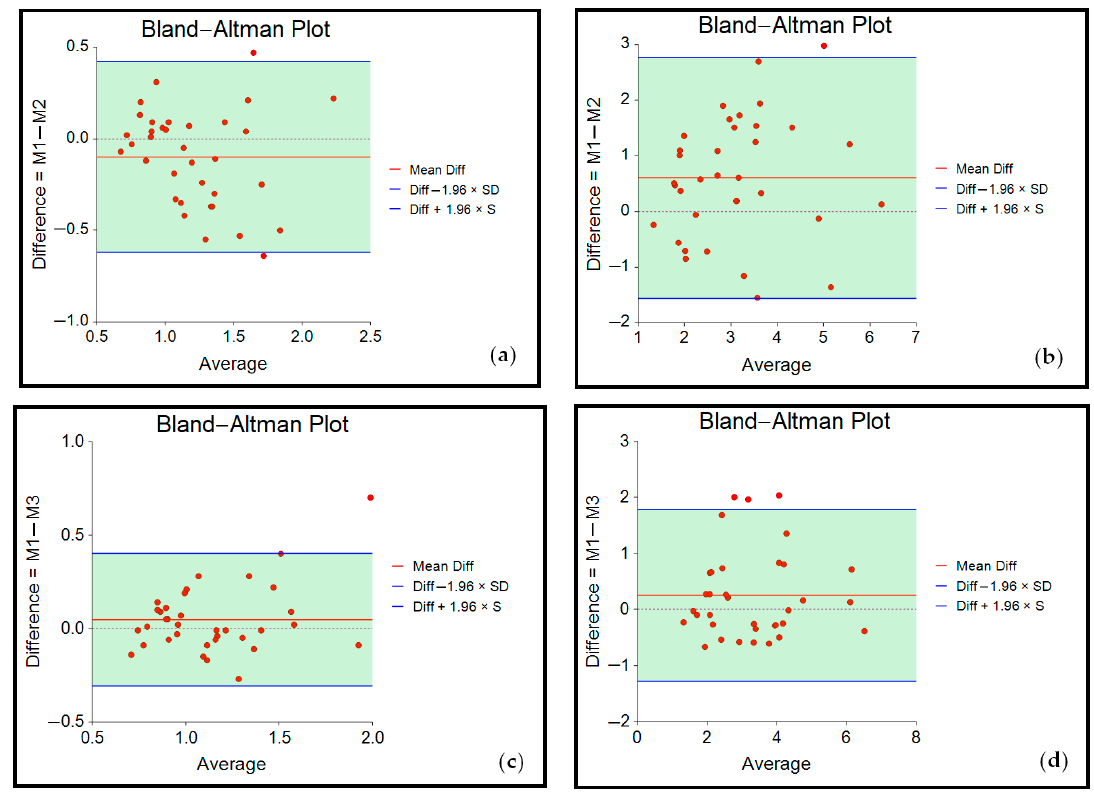
Figure 4. Bland–Altman plots showing agreement of measurements for ( a ) M1 and M2 at 5 mm indentation depth; ( b ) M1 and M2 at 10 mm indentation depth; ( c ) M1 and M3 at 5 mm indentation depth; ( d ) M1 and M3 at 10 mm indentation depth.